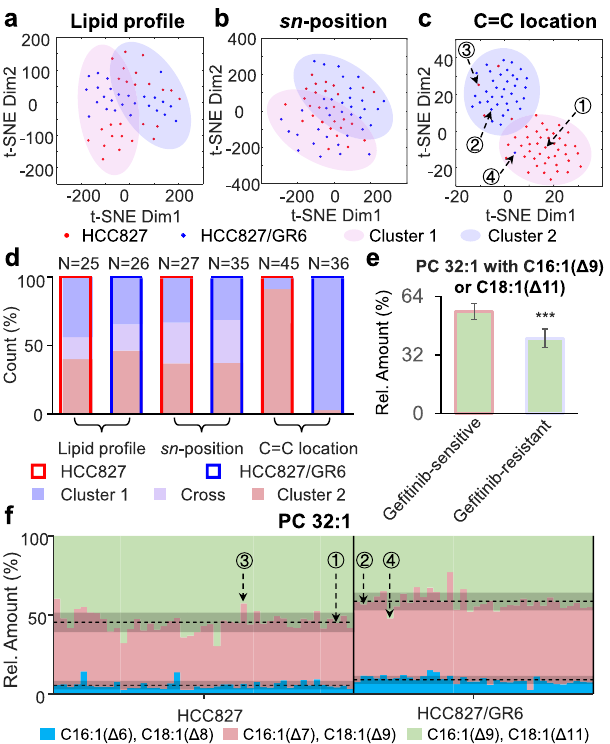
Fig. 5 Discrimination of ge fi tinib-sensitive and ge fi tinib-resistant human lung cancer cells. a – c t -SNE plot of HCC827 and HCC827/GR6 single cells calculated by molecular lipids pro fi le ( a ), sn -position isomer compositions ( b ), or C = C location isomer compositions ( c ). Two cluster areas were circled by k-means clustering results with a con fi dence probability of 0.95. d Cell number distribution in each cluster. e Comparison of the relative abundance of PC 32:1 with C16:1( Δ 9) or C18:1( Δ 11) in ge fi